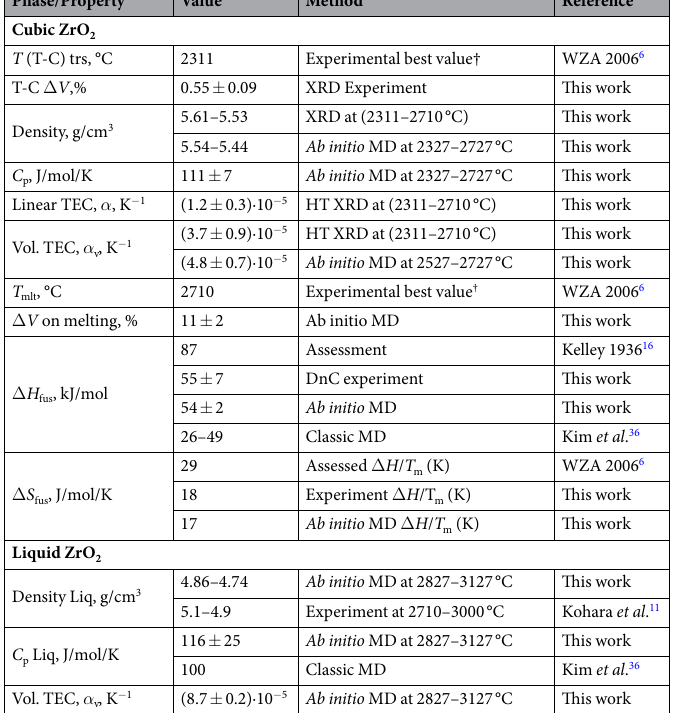
Table 2. Thermodynamic data for cubic and liquid ZrO 2 . † Best values for ZrO 2 tetragonal–cubic (T-C) transition and melting from WZA assessment of experimental results (2311 and 2710 °C) were used for temperature calibration in diffraction experiments in this work. (TEC: Thermal Expansion Coefficient, Vol.: